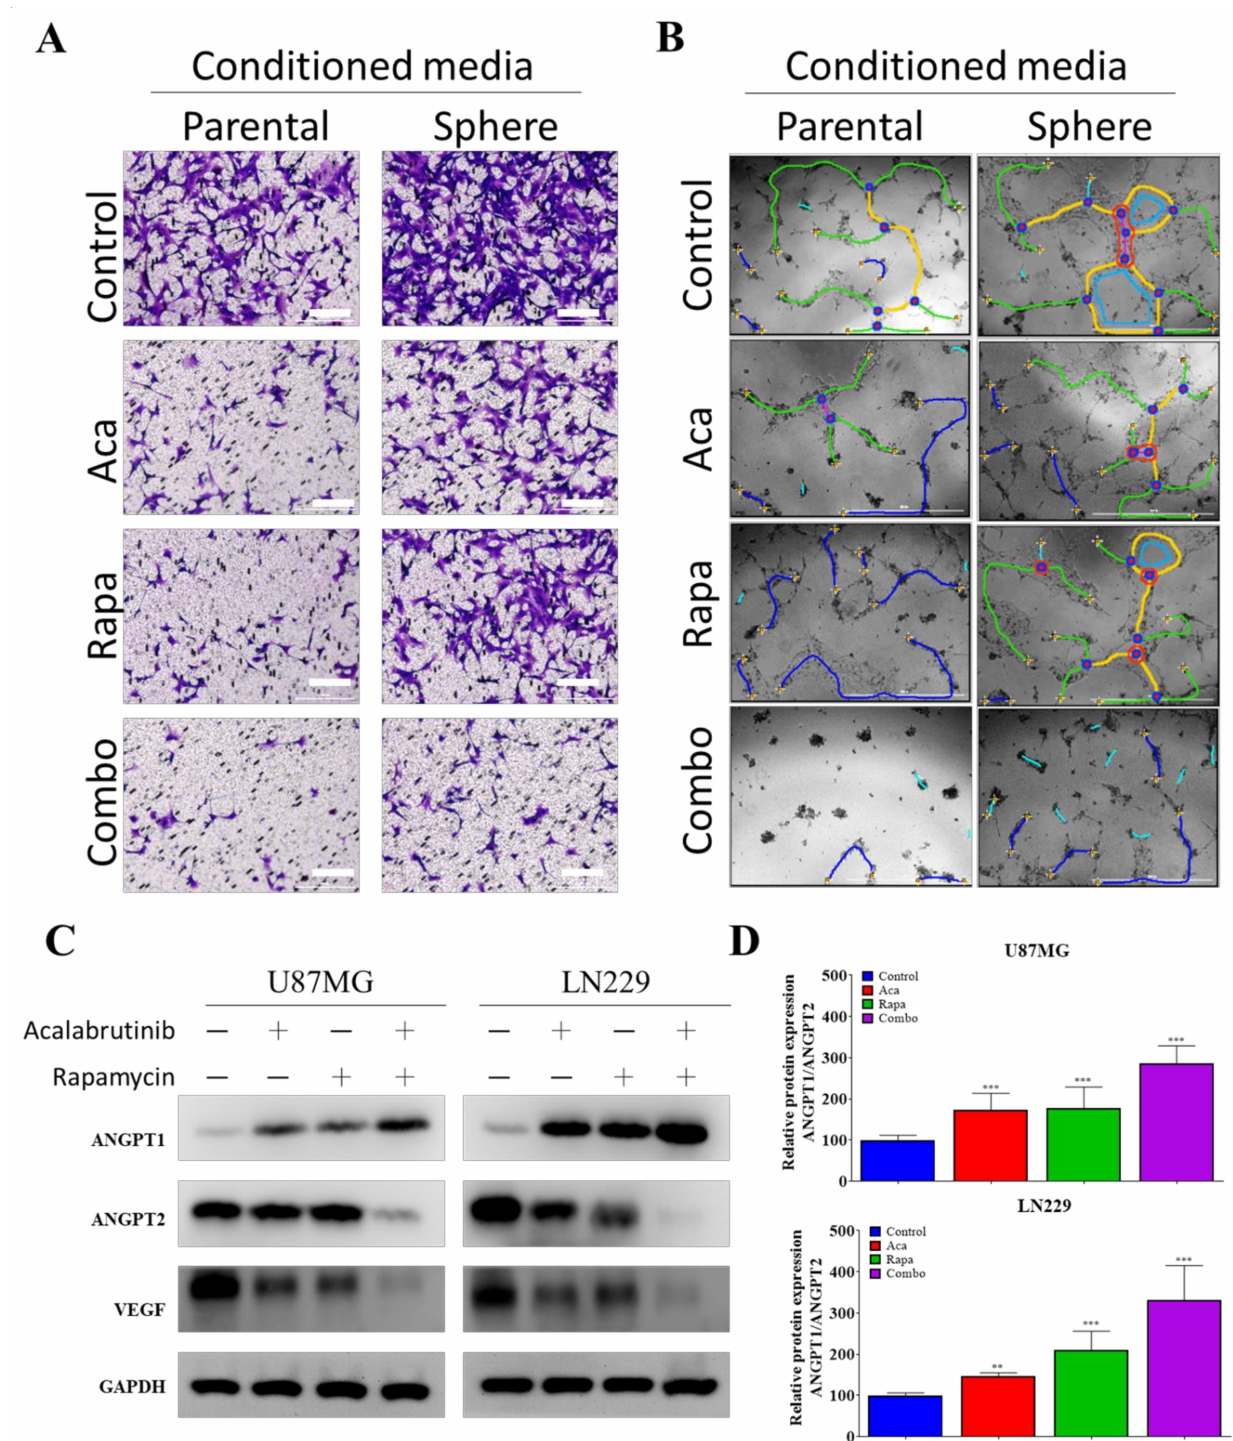
Figure 4. Drug-treated GBM tumorspheres had a moderate effect on the migration and tube formation of HUVECs. A combination of acalabrutinib and rapamycin ( A ) markedly inhibited the migration ability of HUVECs, ( B ) significantly inhibited the tube-formation potential of HUVECs, ( C ) and effectively increased ANGPT1/ANGPT2 ratio and diminished VEGF expression in ( D ) U87MG and LN229 cell lines. Yellow, fully formed mature tubes; red, nodes; blue, budding tube in process of forming; green, branches. ** p < 0.01; *** p <